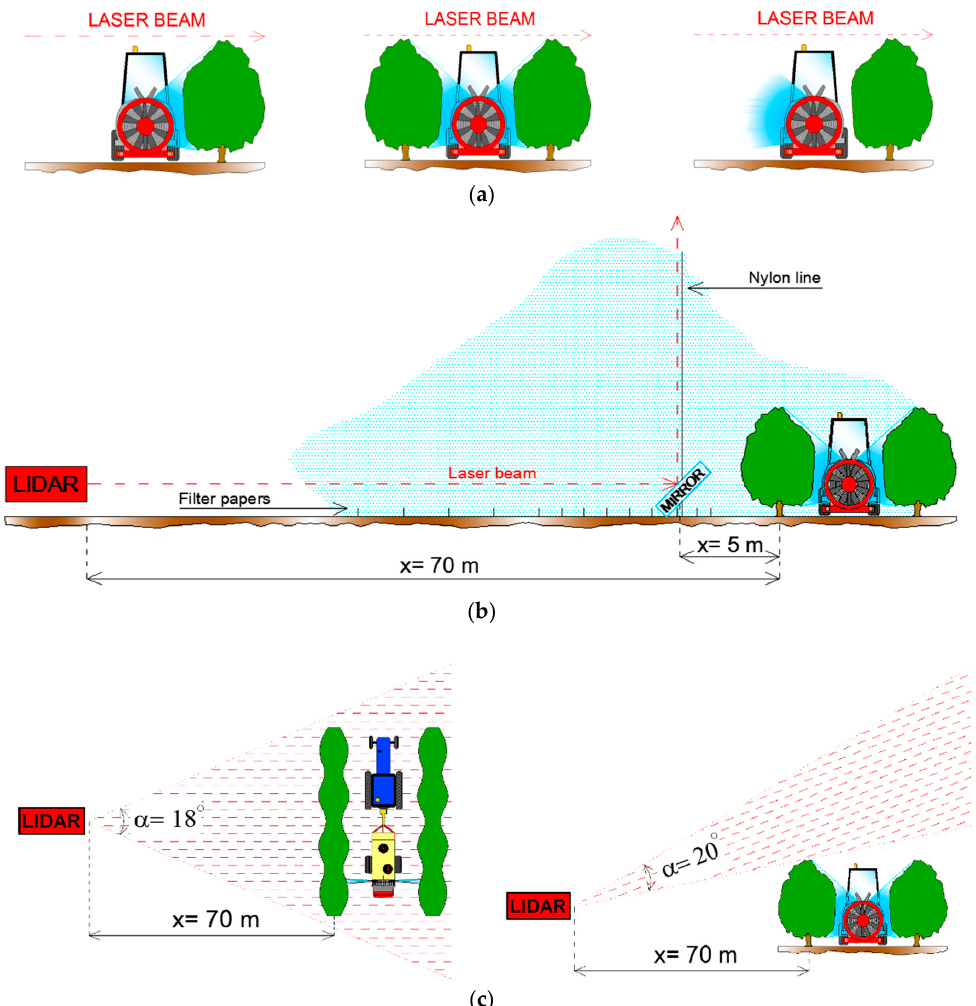
Figure 2. ( a ) Lidar measurements of the spray flux over the canopy (staring mode). Spraying sequence followed by the sprayer; ( b ) Comparison between lidar and passive collector (ISO 22866 [1]) measurements of the spray drift; ( c ) Position of the lidar system and air-assisted sprayer while the lidar was scanning the spray plume: (left) PPI scanning configuration; (right) RHI (vertical) scanning configuration.